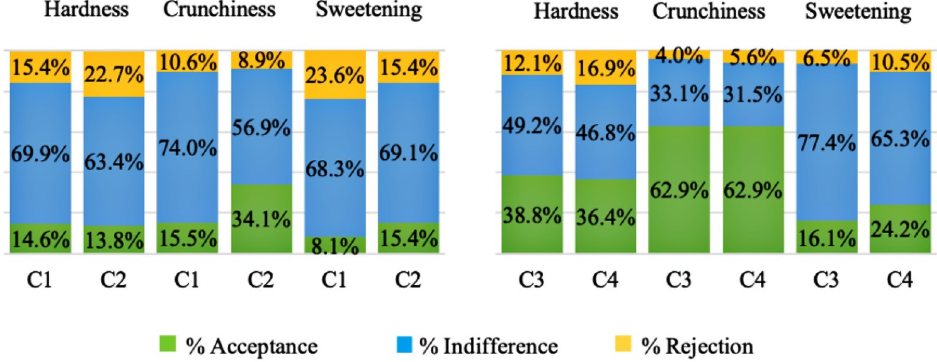
Fig 4. Hardness, crunching and sweetness of the cookies. Ideal rating percentages above and below ideal hardness when biting and crunching and sweetness of the cookies. C1—wheat flour cookies (control1), C2–50% xiquexique flour (100 mesh) cookies, C3—whole wheat flour cookies (control2) and C4–50% whole xiquexique flour (28 mesh) cookies. � Perceived by more than 20% of consumers, with a significant decrease of at least 1 point in the average overall